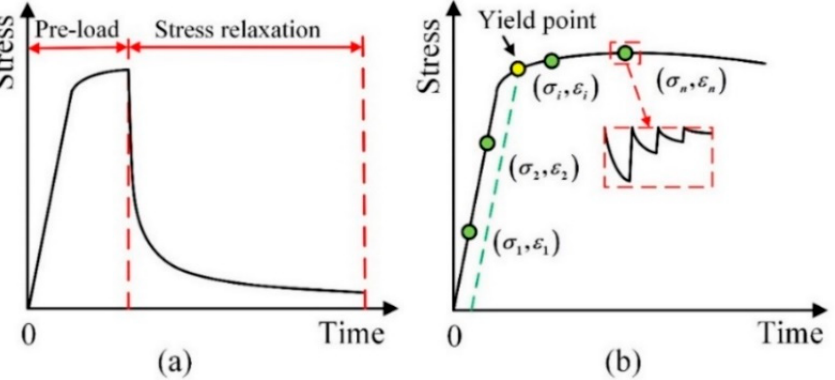
Figure 2. Schematic of the mechanical testing procedures, ( a ) the whole stress relaxation process consists of loading stage and stress relaxation (SR) stage, ( b ) repeated stress relaxation (RSR). Table 1. Experimental design for the uniaxial tensile, stress relaxation (SR) and repeated stress relaxation (RSR).